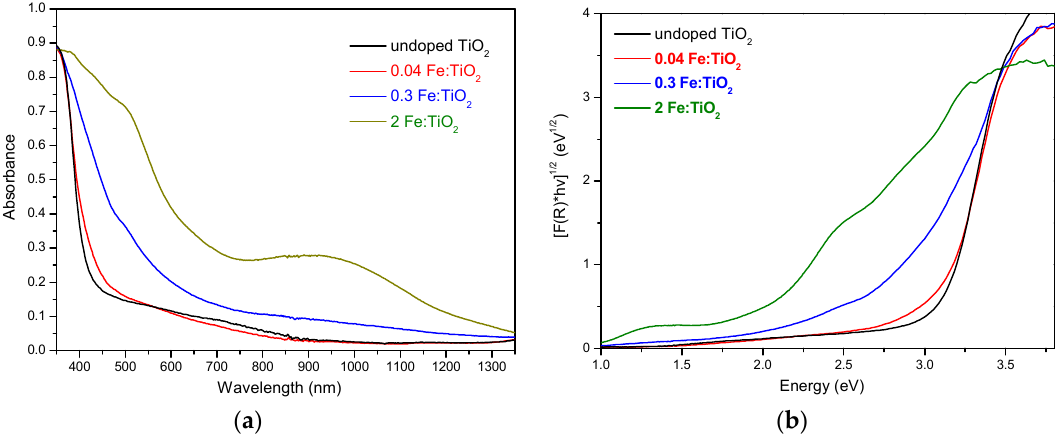
Figure 2. UV–Vis absorption ( a ) and Kubelka–Munk ( b ) spectra of undoped and doped samples.